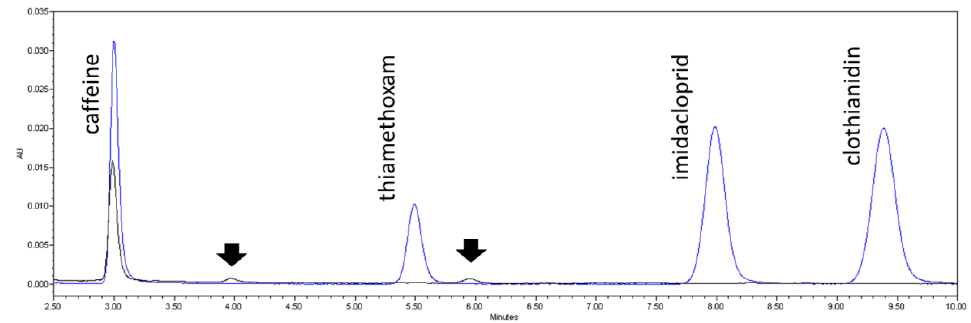
Figure 6. Overlaid chromatograms of samples from photolysis assay at time zero (blue line) and after 10 min of irradiation (black line). Arrows point to the formation of two possible